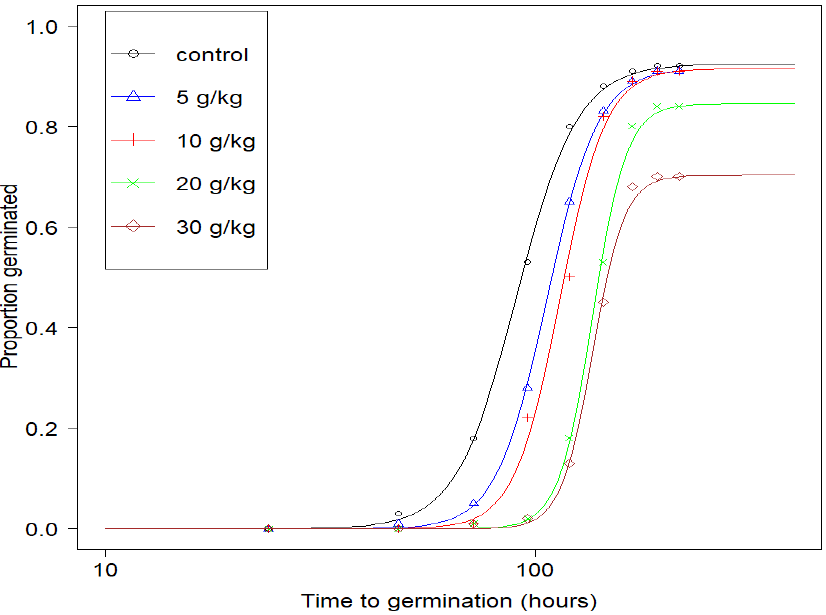
Figure 1. Germination curves for Medicago sativa seeds in 0 (control), 5, 10, 20 and 30 g / kg diesel fuel contaminated soils.